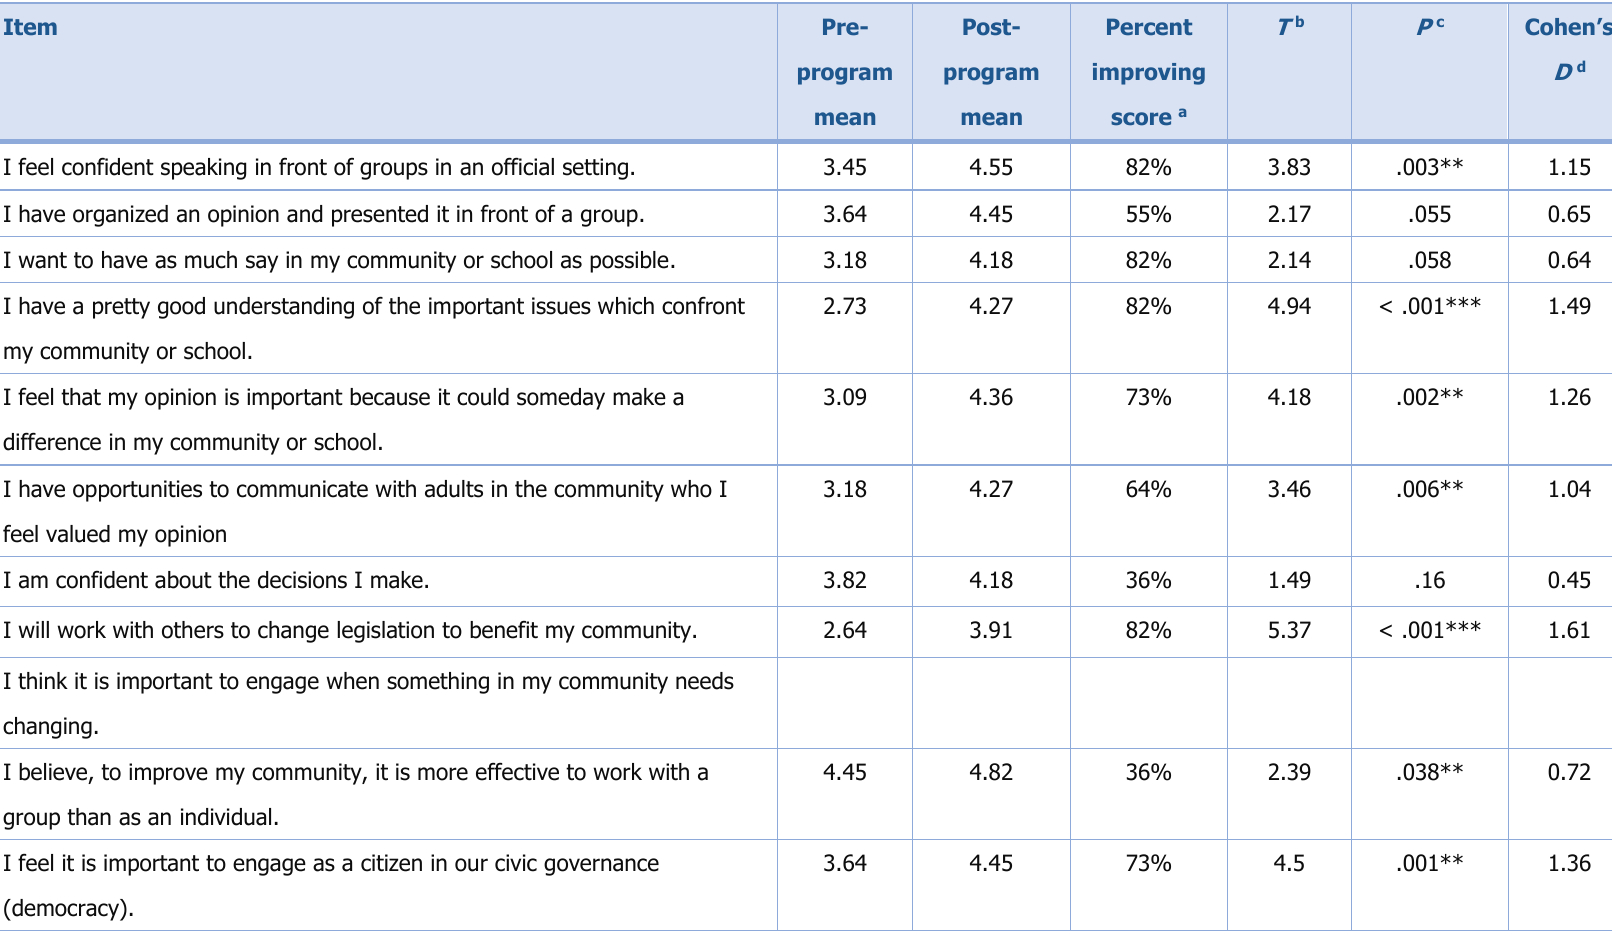
Table A1. Means, T-Scores, P-Values, and Effect Sizes Comparing Youth Survey Results Before and After Participation in Superior